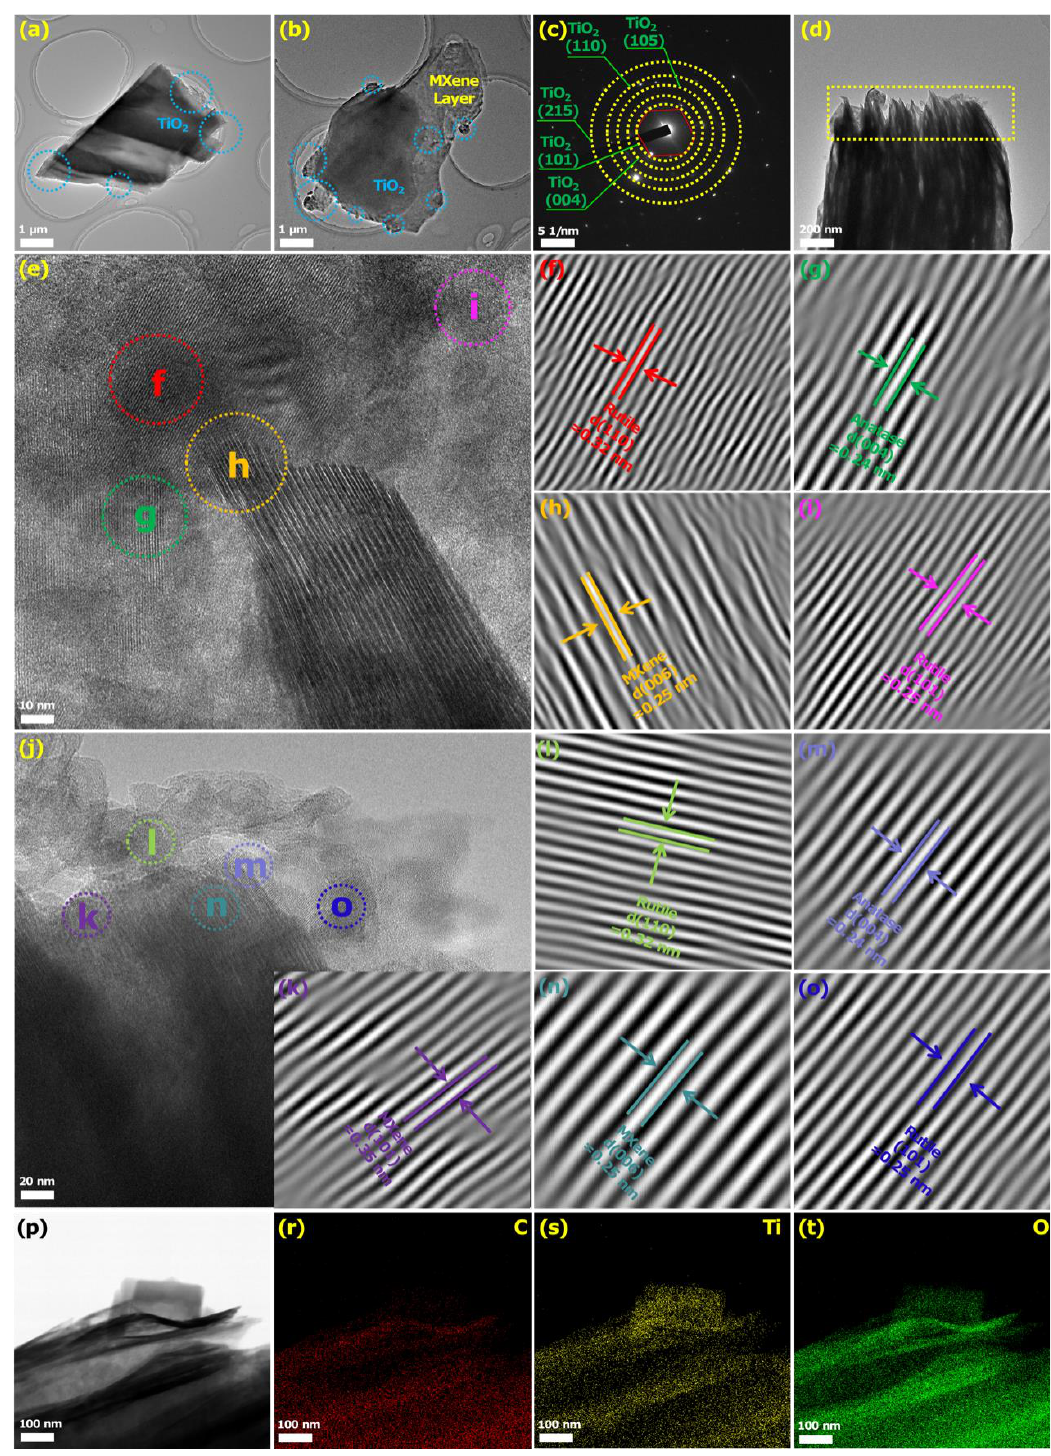
Figure 4. ( a , b ) TEM of MT-600 °C and ( c ) the corresponding SAED patterns. ( d ) TEM of MT-600 °C and the corresponding HRTEM images of ( e – j ). The spacing images of TiO 2 (anatase, rutile) and MXene planes of HRTEM images of (e) and (j) with the selected areas ( f – i ) and ( k – o ), respectively. ( p ) Bright-field scanning TEM image and EDX elemental mapping of the ( r ) C, ( s ) O, and ( t ) Ti. In addition, further characterization by Fourier transform infrared spectroscopy (FT- IR) showed that the MT-600 °C contained vibrational absorption peaks belonging to MXene and TiO 2 (Figure S6). Furthermore, the physicochemical parameters of MT-600 °C were investigated by N 2 adsorption-desorption isotherms, and the results showed that its